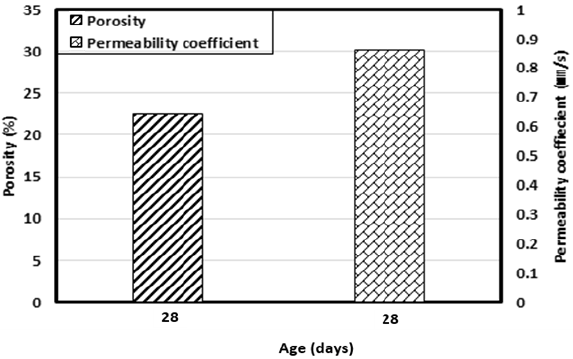
Figure 9. Porosity and permeability coefficient.